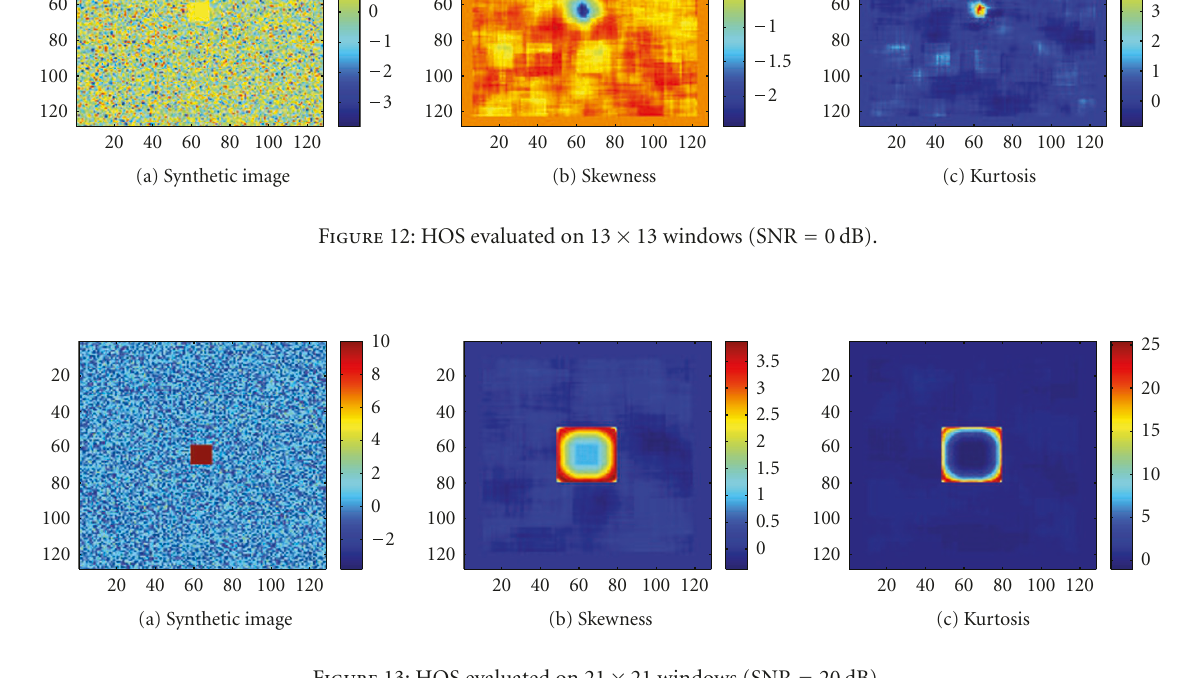
Table 4: Detection performances of the HOS (contrast), with an SNR of 20dB, in function of the size of the computation window. Contrasts Window size